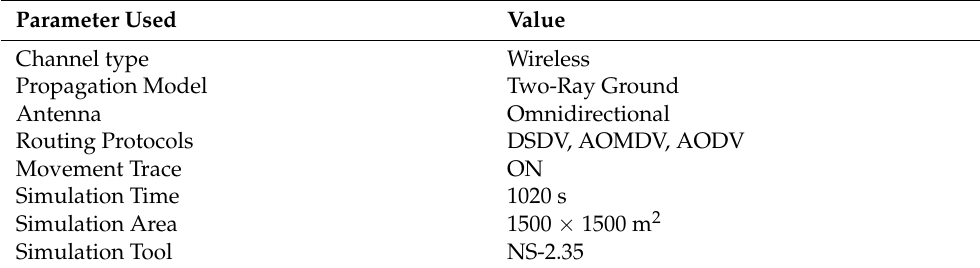
Table 2. Various Simulation Parameters for